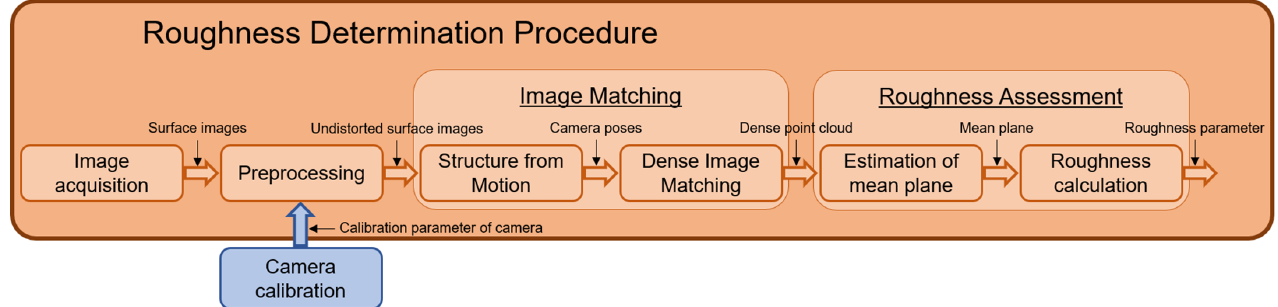
Figure 3. Schematic of the roughness determination procedure.